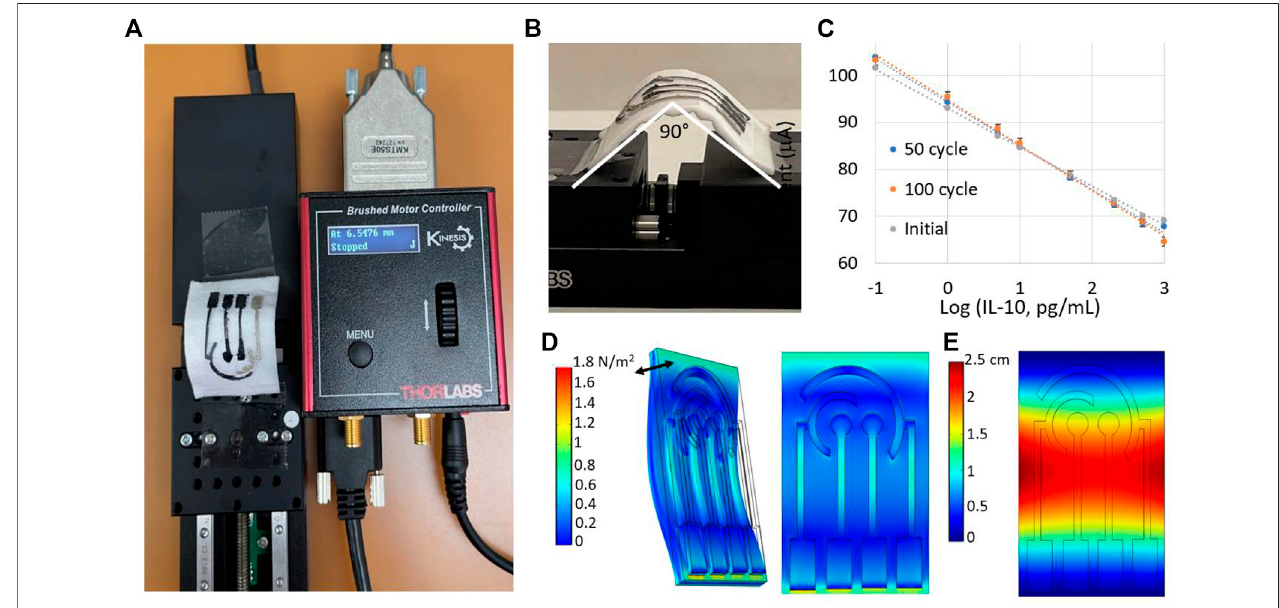
FIGURE 7 | (A) Setup for the motorized translation stage. (B) Evaluation of the sensor ’ s performance under different degrees of bending, with 90 ° being the maximum bending angle. (C) Calibration plots of the IL-10 sensor after 50 and 100 cycles of bending. Measurements were repeated three times for each protein concentration. Modeling (D) stress and (E) displacement of the electrodes under sinusoidal bending. The double arrow in (D) shows the direction of bending.